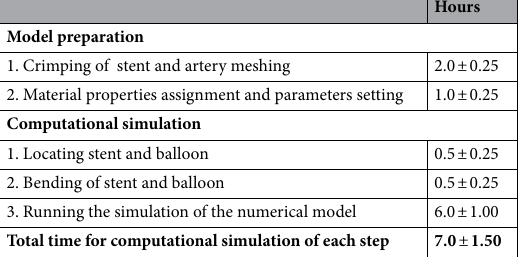
Table 7. Average processing times for computational stenting simulations for clinical